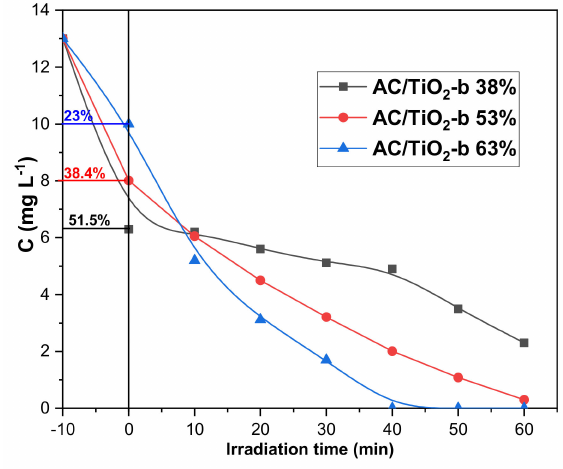
Figure 7. CBZ concentration in the presence of AC/TiO 2 ball composites as a function of irradiation time: [CBZ] = 13 mg L − 1 , [AC/TiO 2 -b] = 0.1 g L − 1 and Xe lamp.